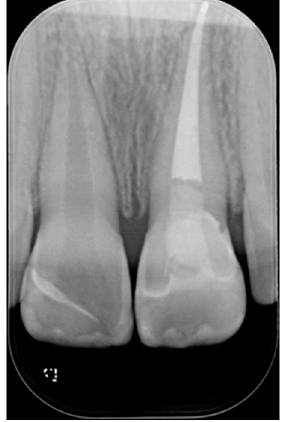
Figure 39. At 1.5 years, post-operative radiographic view. Reprinted from Restauri diretti nei settori anteriori, G. Paolone, S. Scolavino, © 2021, with permission from Quintessence Publishing Italy.